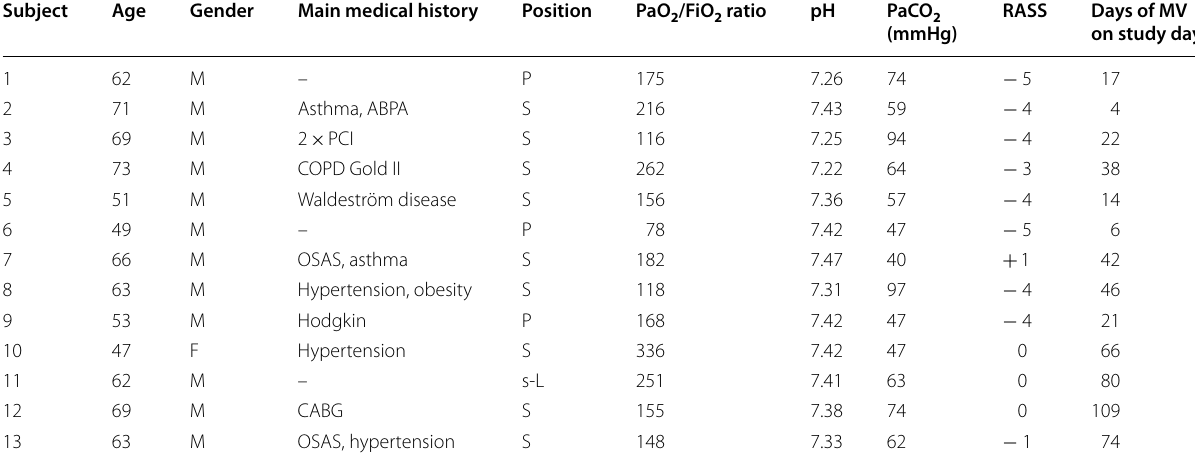
Table 1 Patient